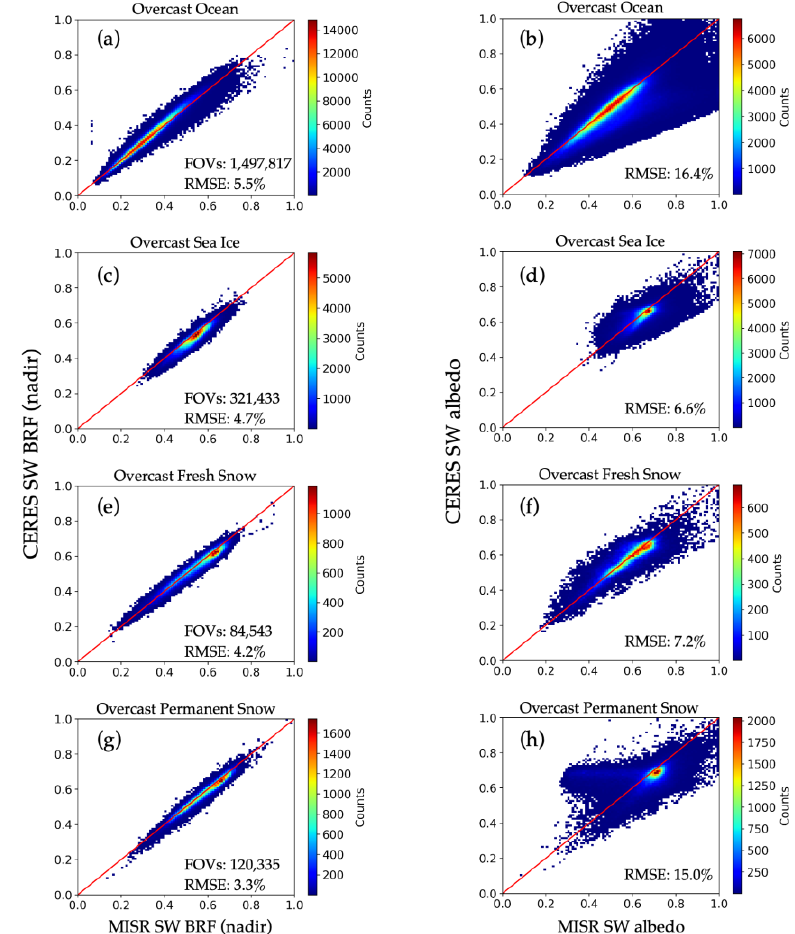
Figure 1. All collocated CERES-MISR instantaneous samples of near-nadir SW BRFs and SW albedos for ( a , b ) CERES overcast ocean scenes; ( c , d ) CERES overcast sea ice scenes; ( e , f ) CERES overcast fresh snow scenes; and ( g , h ) CERES overcast permanent snow scenes. Bin size is 0.01 for both BRF and albedo plots.